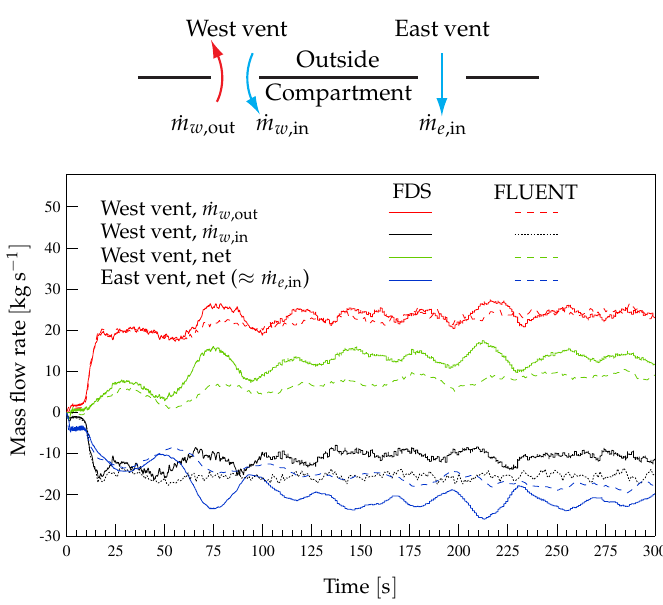
Figure 20. Same results as in Figure 5b, but obtained with FDS and FLUENT for Case G-4 ( T in = 1500 K).